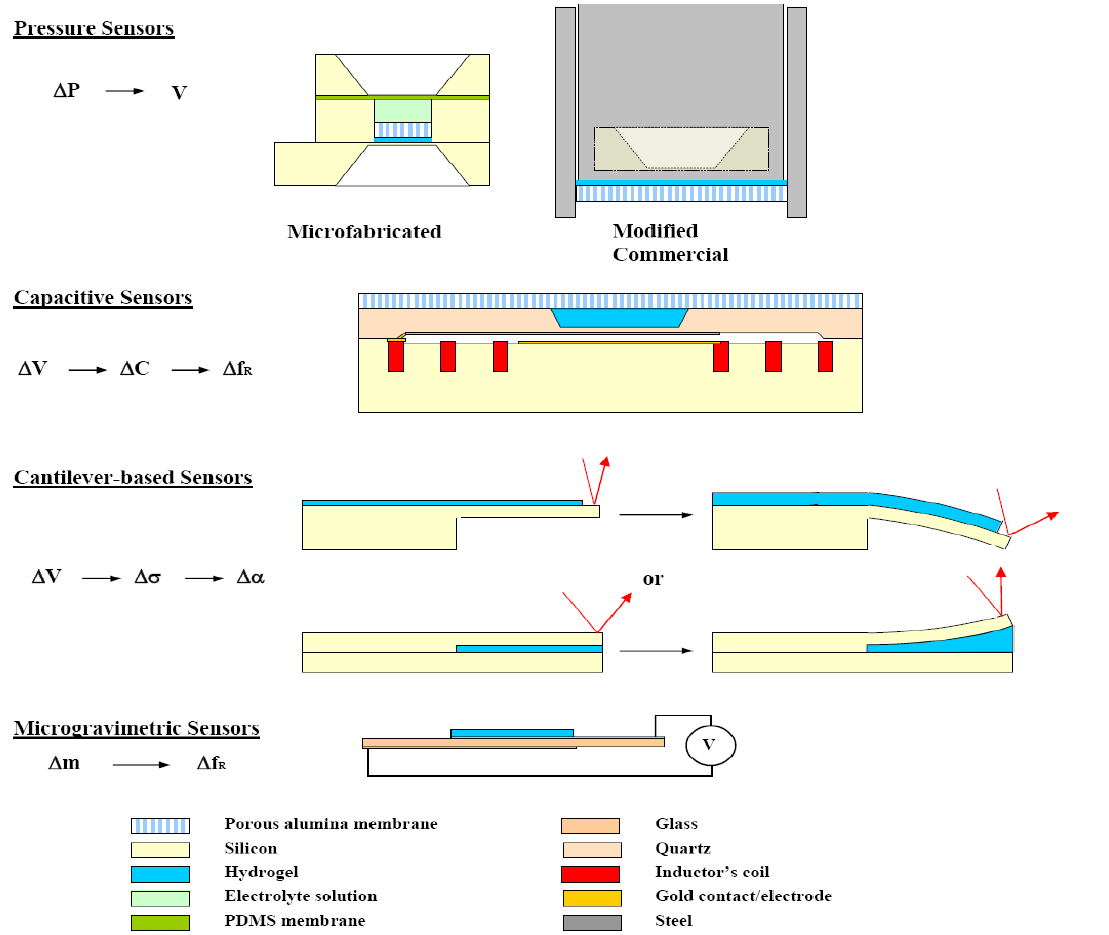
Figure 7. Schematics of the principal mechanical transduction schemes. P: pressure, V: potential difference,  V: volume change, C: capacitance, f R : resonance frequency,  : mechanical stress,  : angle, m: mass, f: